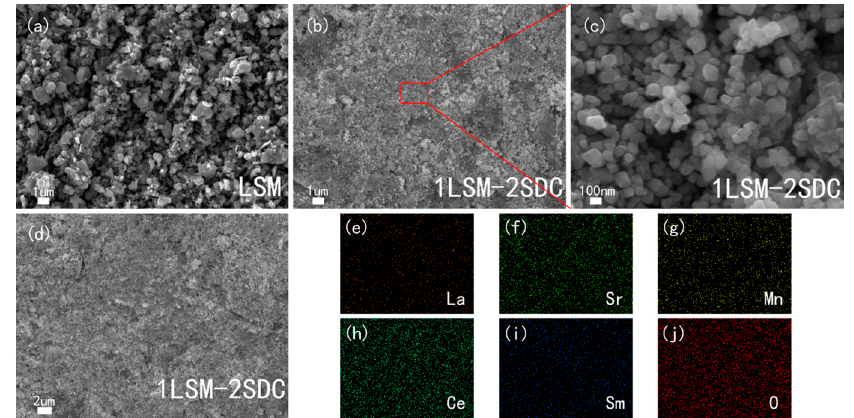
Figure 2. SEM of ( a ) LSM (La 0.1 Sr 0.9 MnO 3 − δ ) material, ( b – d ) original LSM-SDC (La 0.1 Sr 0.9 MnO 3 − δ -Ce 0.8 Sm 0.2 O 2 − δ ) composite (1:2, wt:wt, without co-fire treatment), ( e – j ) elemental mappings of the LSM-SDC composite (1:2, wt:wt). The elemental mappings were taken from Figure 2d.